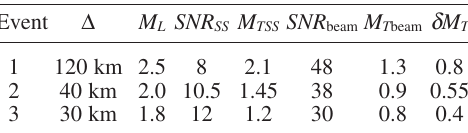
Table I. Listing of observed SNR ’s measured at a single site of the CDC array and on the CDC beam for different events. For more details see